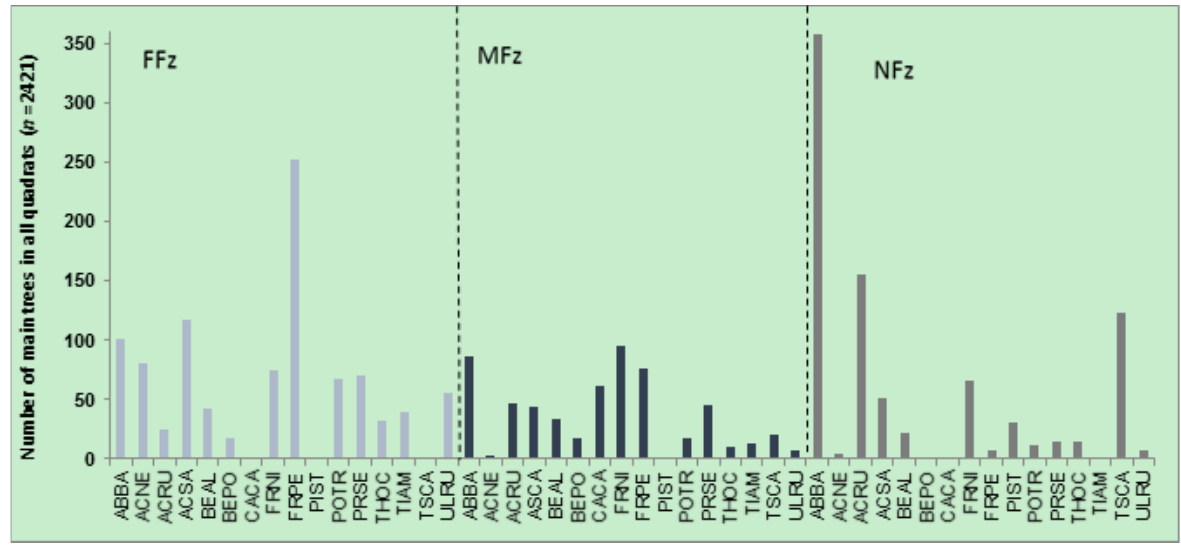
Figure 8. Composition and distribution of tree specimens in different study areas. The zones with a high flood recurrence interval (FFz: 0–20 yrs) are represented in blue color; zones with an intermediate flood recurrence interval (MFz: 20–100 yrs) are in black color, and grey color for no-flood zones (NFz) (Note: Only tree species with over 25 individuals are shown